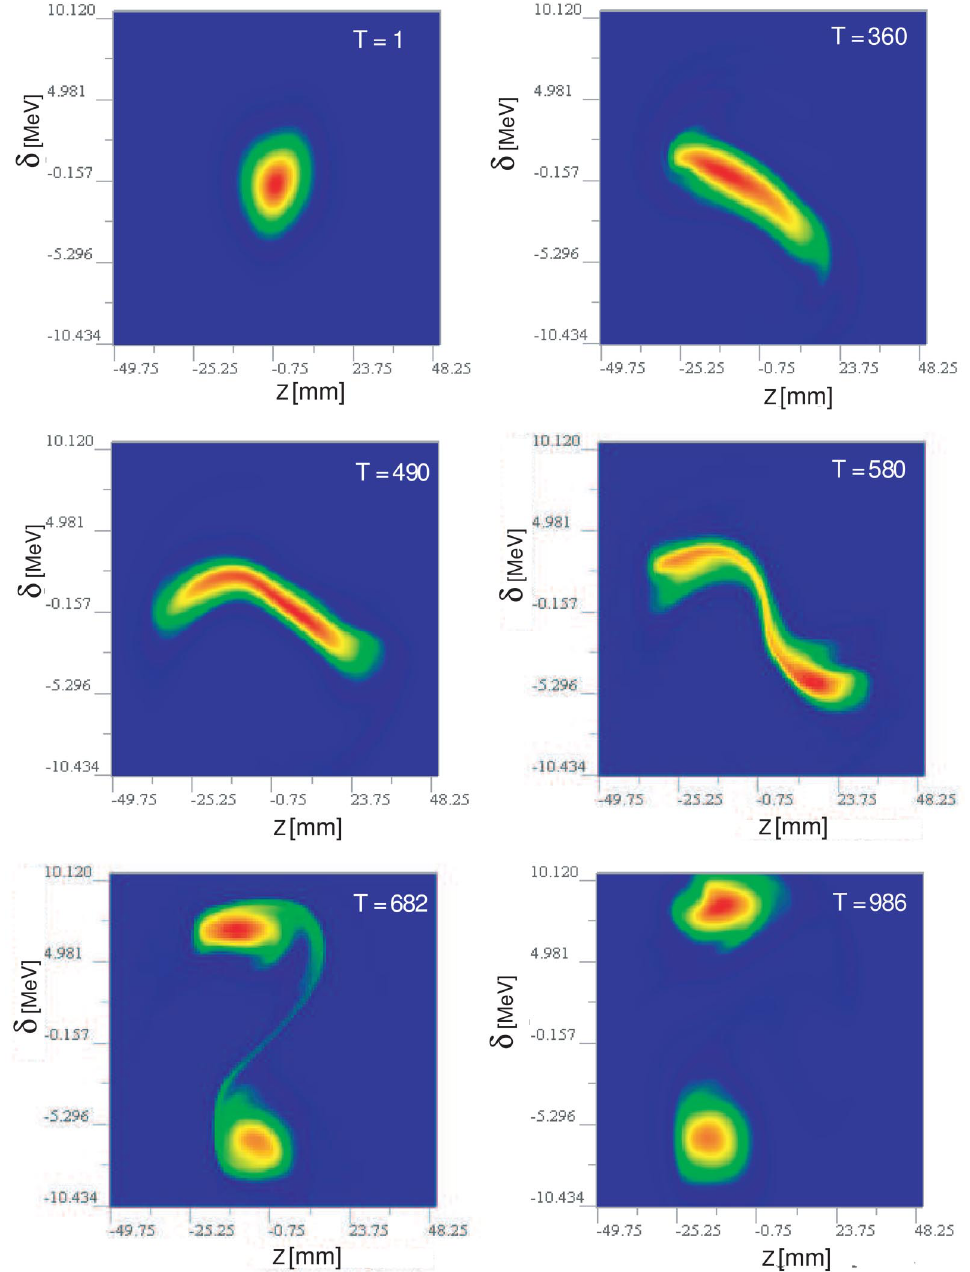
FIG. 7. (Color) Dynamics of the head-tail single-bunch instability is shown in the phase plane (cid:5) z; (cid:2) (cid:6) for 2 mA bunch current. Time in the number of turns is indicated in the figure. At t > 600 turns, the bunch splits in revolutions per synchrotron period. The data are interpo- lated as the sum of